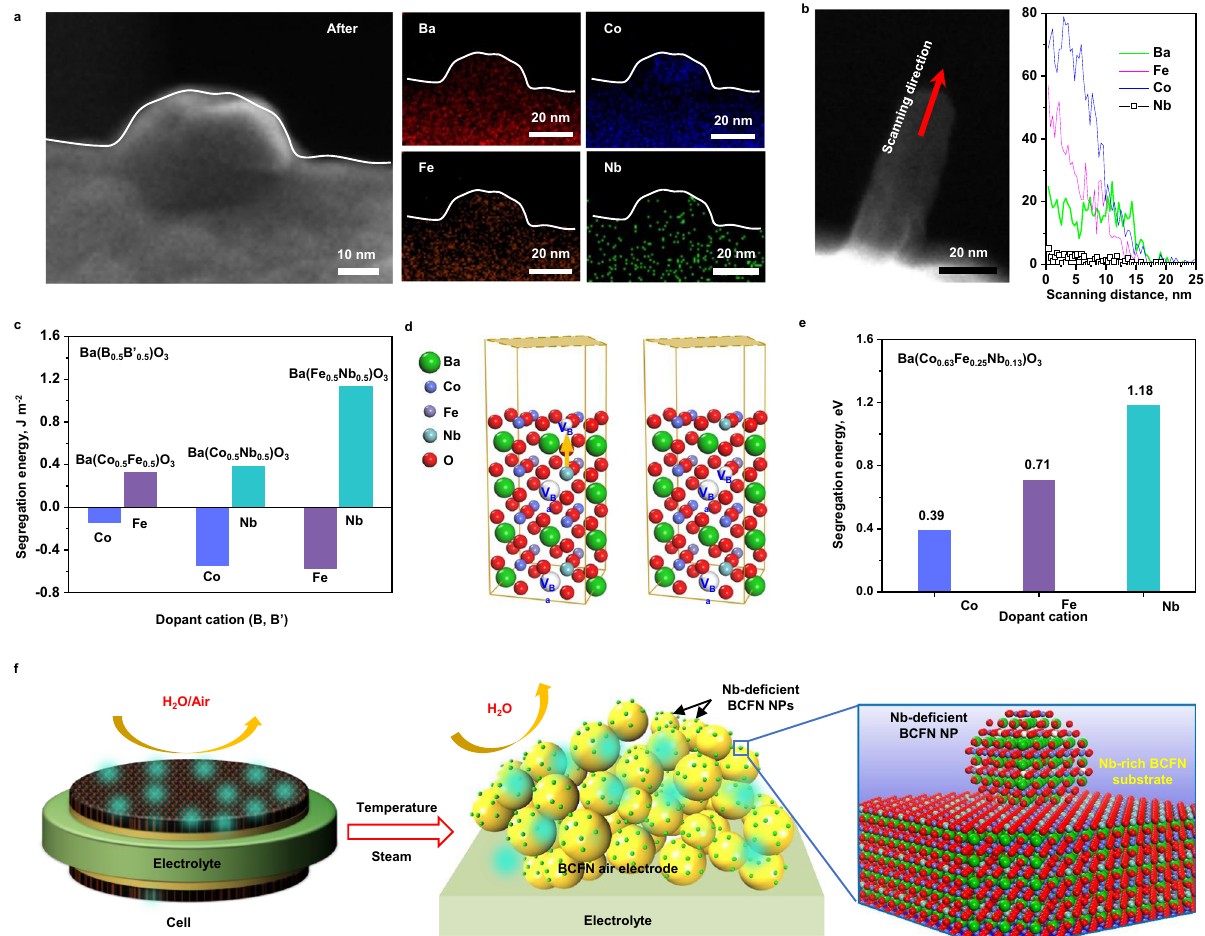
Fig. 5 Formation of the high-performance air electrode of BCFN covered with fi ne BCFN NPs with less Nb. a . TEM image and elemental (Ba, Co Fe, and Nb) mapping of a BCFN grain after electrochemical testing at 650 °C; b . Elemental pro fi le along the scanning line shown in the TEM image; c . Comparison of computed segregation energies (J m − 2 ) for stoichiometric Ba(B 0.5 B ′ 0.5 )O 3 (B,B ′ = Co, Fe, or Nb); d . Illustration of CoO-terminated BCFN(001) surface models representing segregation of Nb from the bulk to the surface; e . Computed segregation energy (eV) for three different dopant cations of Ba 0.9 (Co 0.63 Fe 0.25 Nb 0.13 )O 3 ; and f . A schematic illustration of the formation of Nb-de fi cient BCFN NPs on the BCFN air